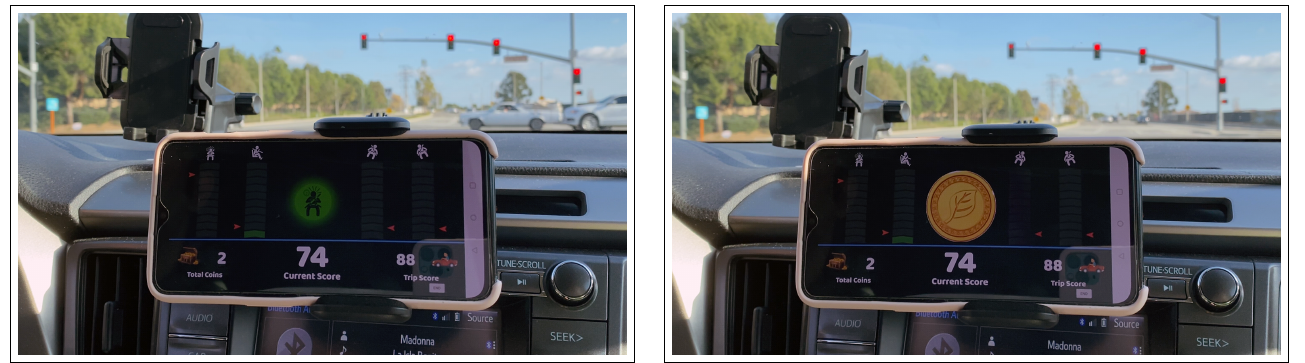
Figure 1. AutoCoach feedback and